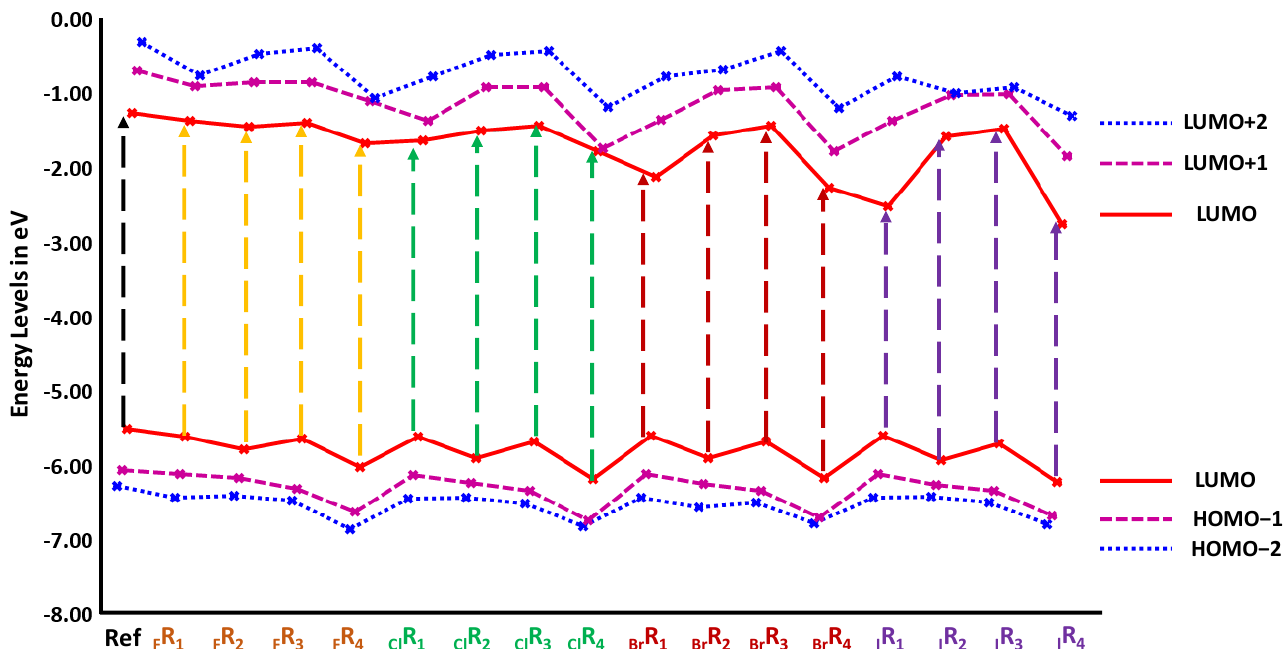
Figure 3. Energy levels of HOMO − 2 to LUMO+2 and values are given in eV for all newly designed molecules compared with reference (R) molecule.